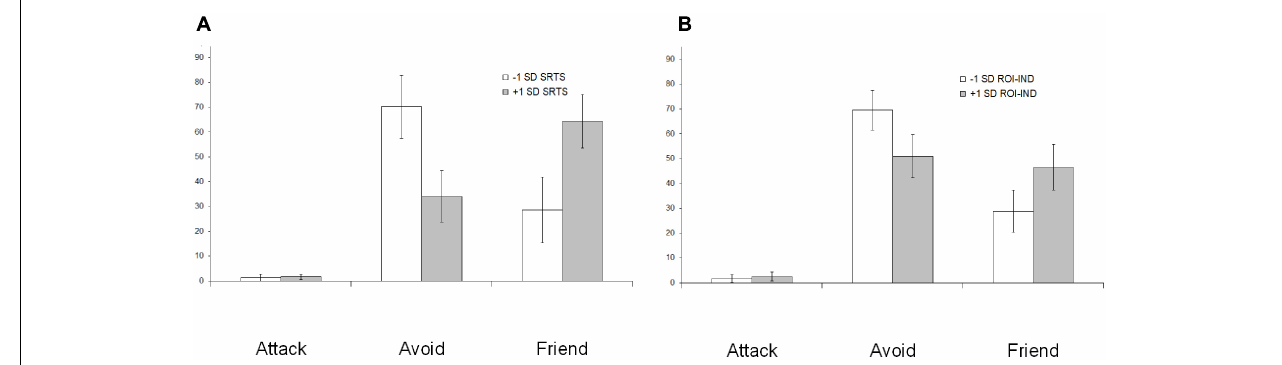
FIGURE 2 | The interaction between behavioral choice in the social interaction task on the one hand, and SRTS scores after individualism priming (A) and associated DMN connectivity (B) in the preceding resting state on the other hand. Participants who spontaneously thought more about the self after individualism priming and showed higher connectivity between the DMN and the left temporal pole during the resting state (empty bars) less frequently choose avoidant and more frequently choose friendly behavior relative to participants who thought more about the self after collectivism priming and showed higher connectivity between the DMN and the right TPJ (filled